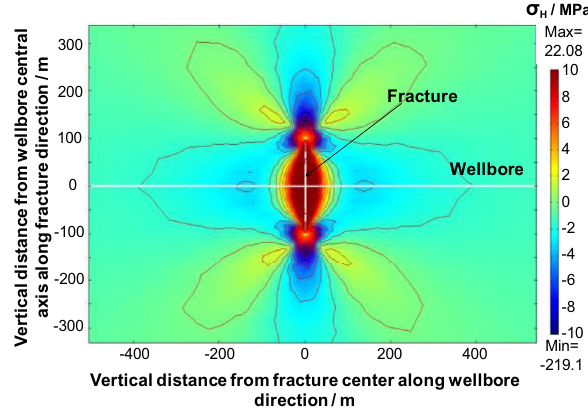
Fig. 4 The maximum horizontal principal stress distribution of a sin- gle fracture in induced stress field on horizontal plane (the numbers in the colour bar indicate the change of stress value)